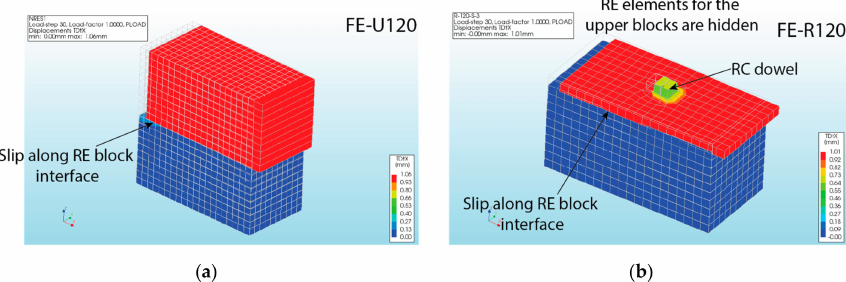
Figure 9. FE deformed shapes at 1 mm shear deformation for: ( a ) FE–U120; ( b ) FE–R120 (FE elements are hidden for the upper RE block of FE–R120.